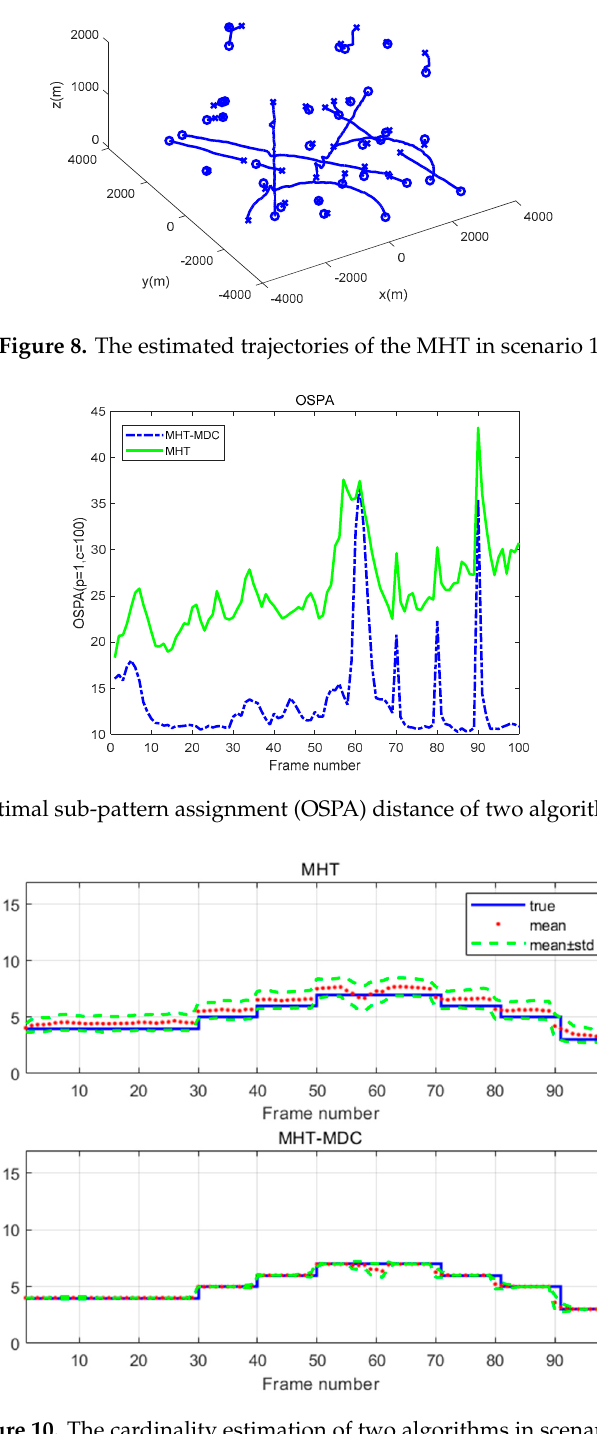
Figure 10. The cardinality estimation of two algorithms in scenario 1.